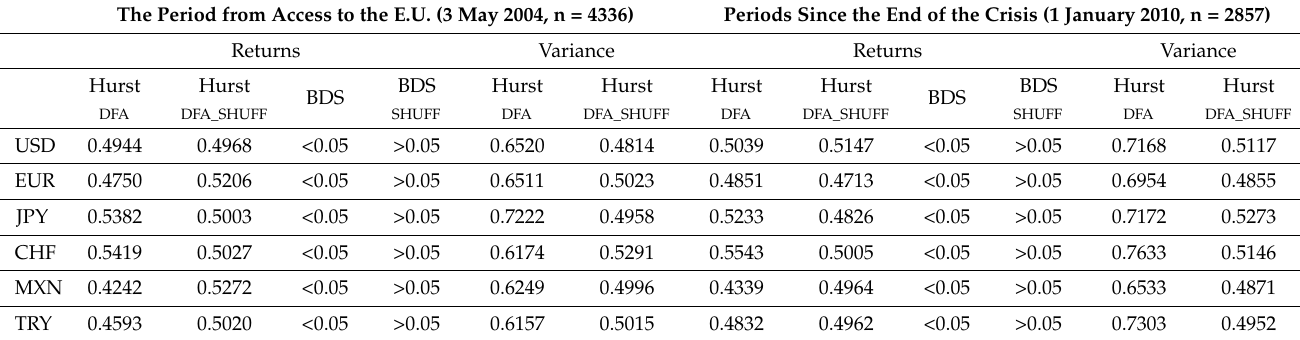
Table 5. The Generalised Hurst Exponent